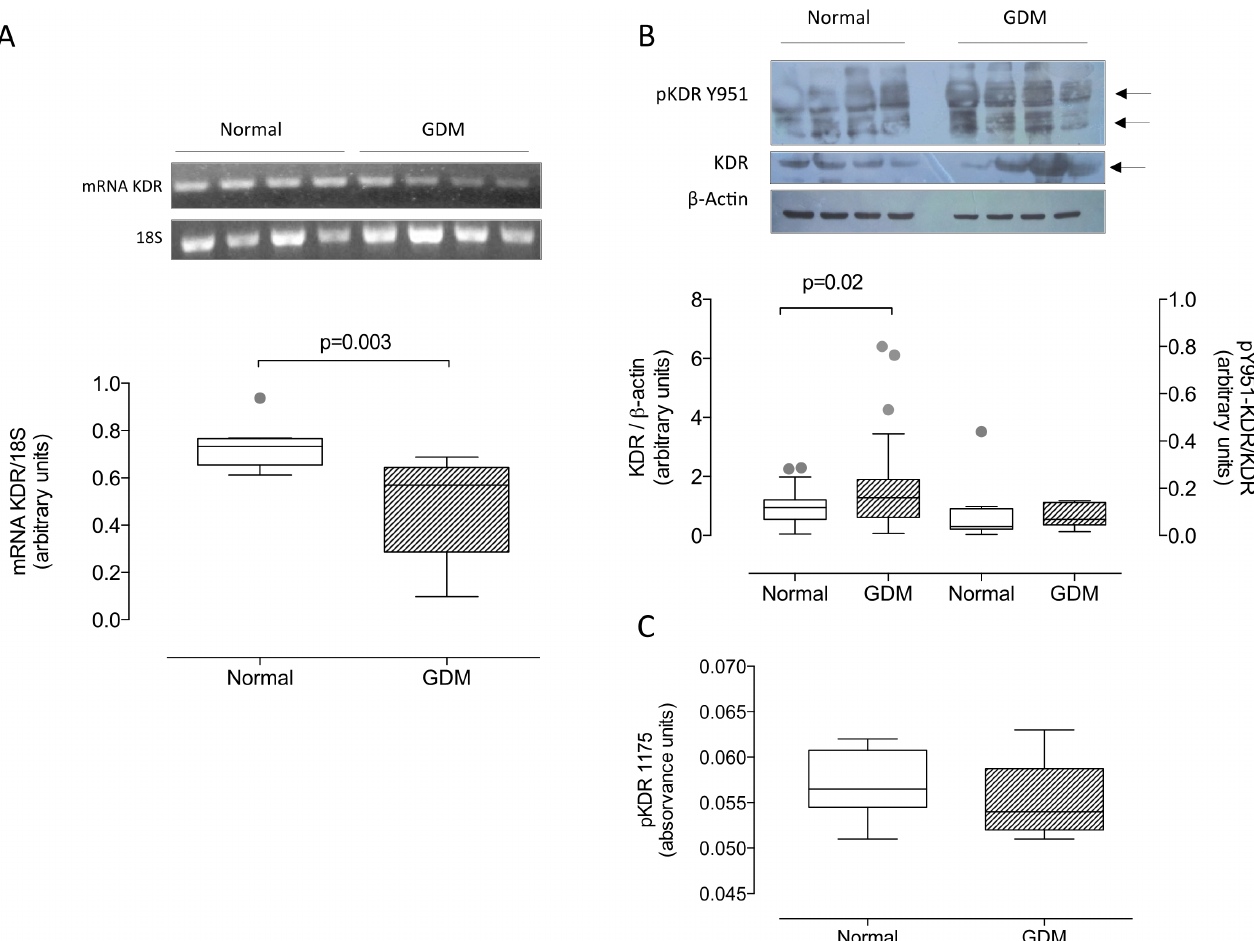
Fig 4. Total KDR and tyrosine 951-and tyrosine 1175 phosphorylation of KDR. A) Representative image of PCR for KDR and 18S in placental homogenates from normal (Normal, white bar) and gestational diabeticpregnancies(GDM, hatchedbar). In the bottom panel is presented densitometic analysisof mRNA KDR/18S. B) Representative images of total KDR (170kDa)and tyrosine 951 phosphorylated (pY951-KDR) (70 kDa) and β -actin (43 kDa) in placentahomogenates. Chart represents densitometry of KDR/ β -actin ratio and pY951-KDR/KDR. C) Optical units at 450 nm were used for estimating the relative amount of KDR phosphorylated in the Y1175 residue. Significantdifferences betweengroups are indicatedwith respectiveP value. In A and C, n = 8 in each group. In B, n = 18 in GDM, n = 20, for total KDR; while 8 per group for Y951. P-value is indicatedin each graph. Outliners are indicatedin